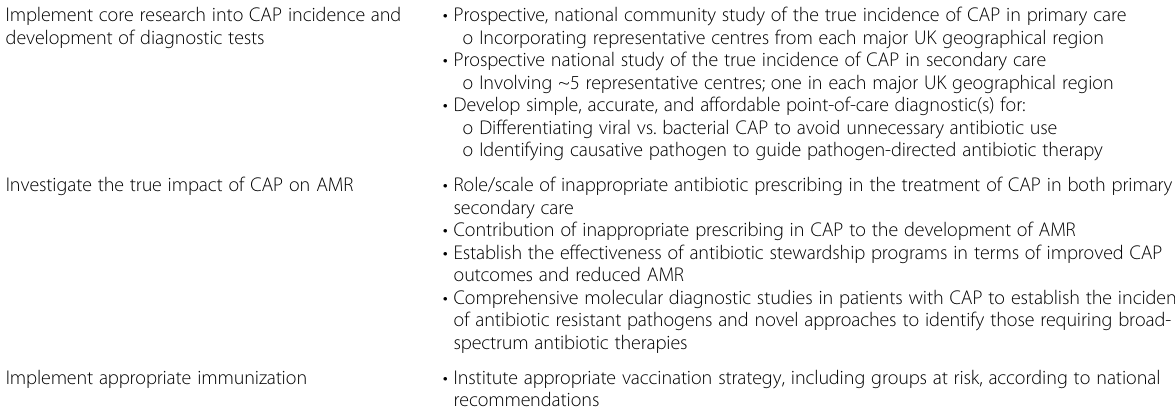
Table 1 Call to Action in the UK Implement core research into CAP incidence and development of diagnostic